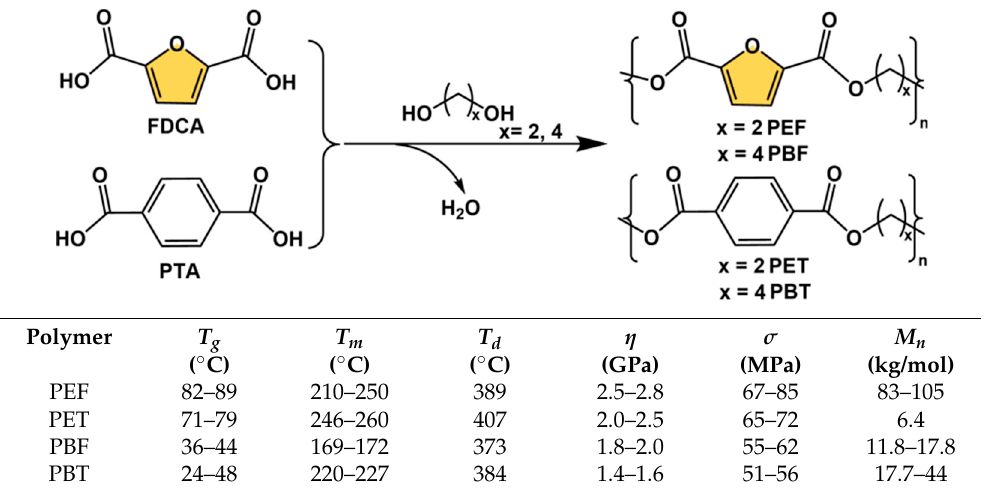
Table 1. Comparison of various properties of PEF vs. PET and PBF vs. PBT.